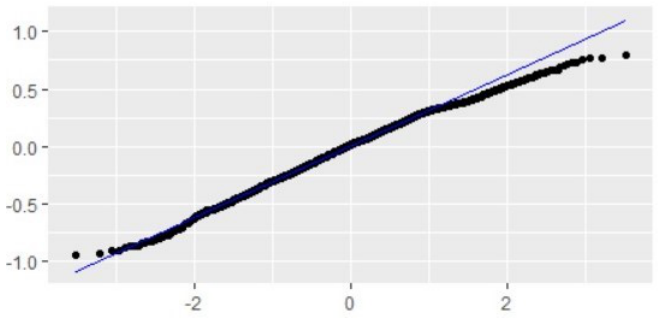
Figure 6. Qq-plot of the discrete time series B H ( t )